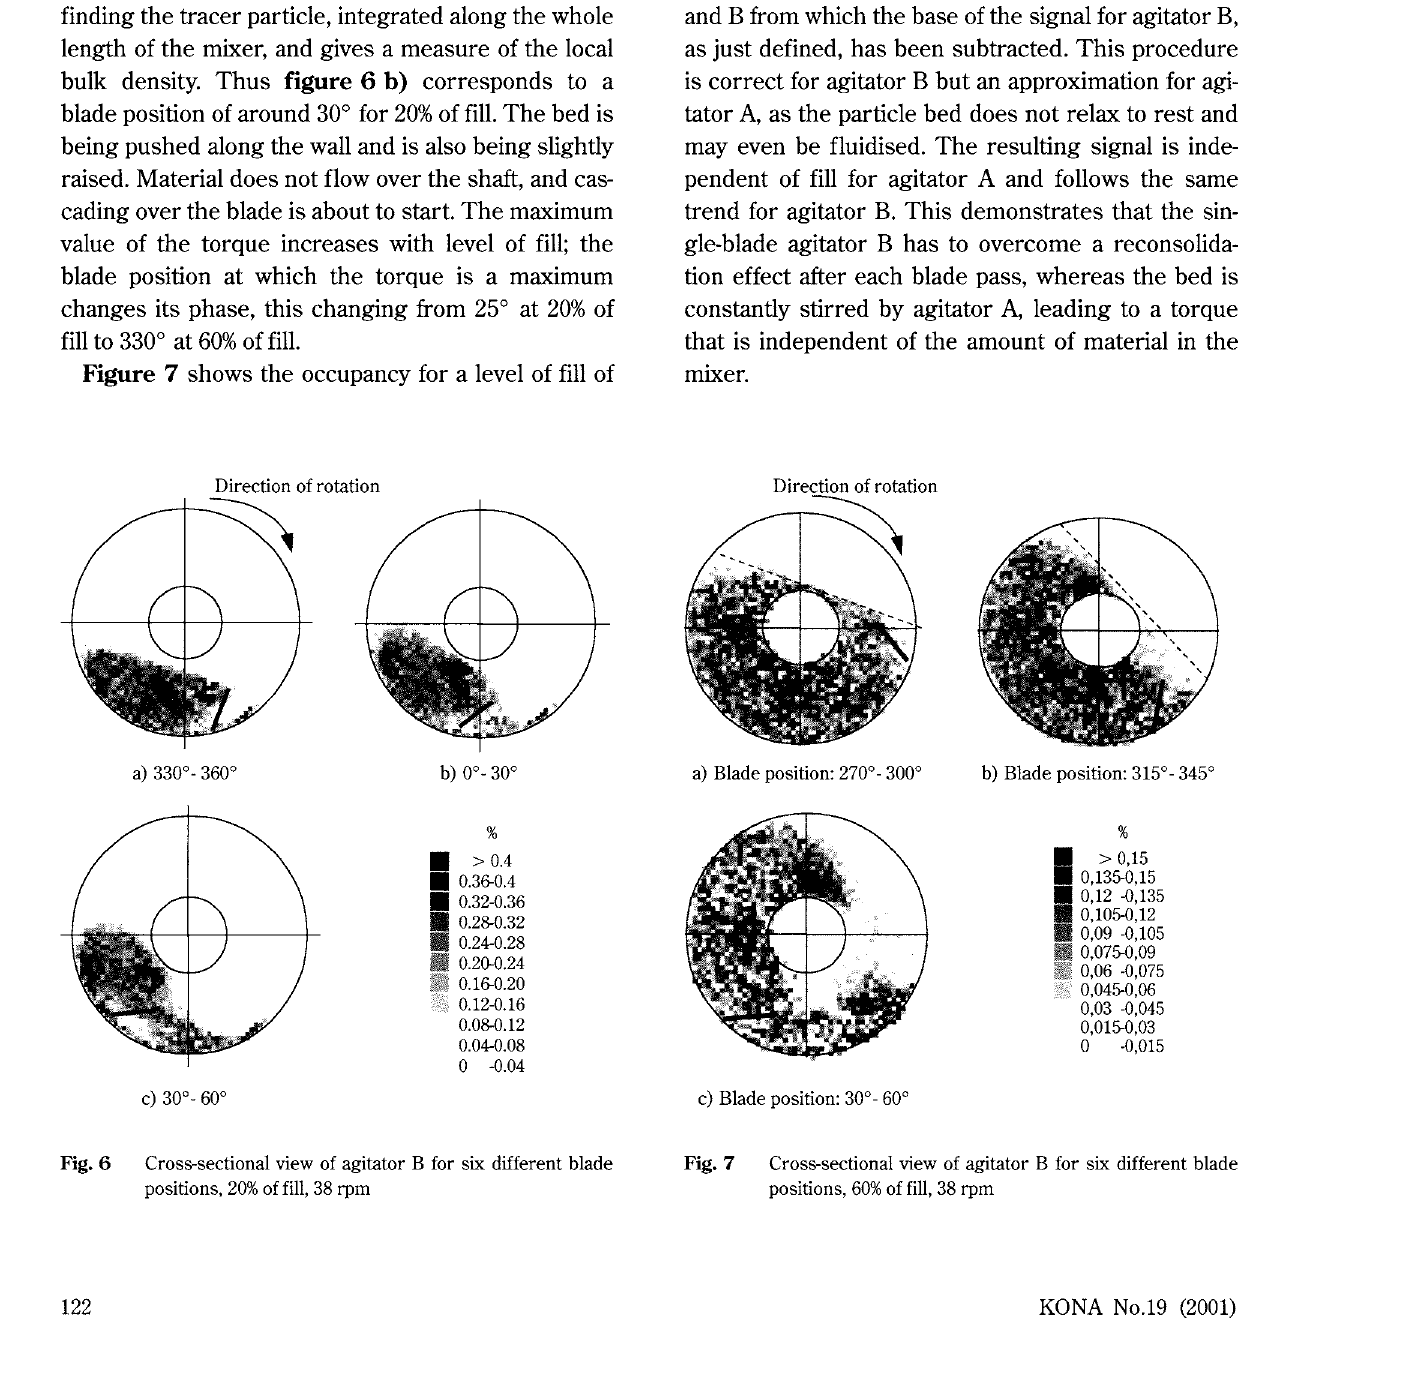
Cross-sectional view of agitator B for six different blade positions. 20% of fill, 38 rpm